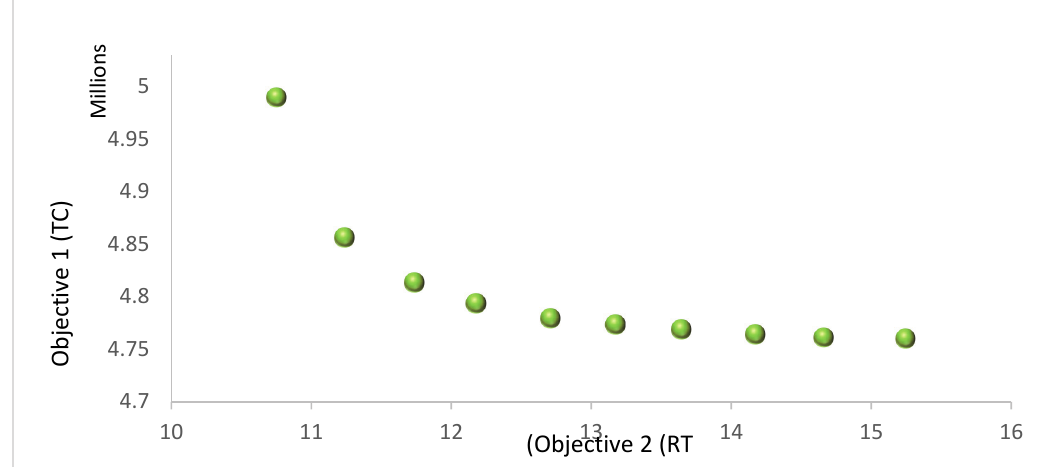
Fig. 7. Pareto points obtained via the new